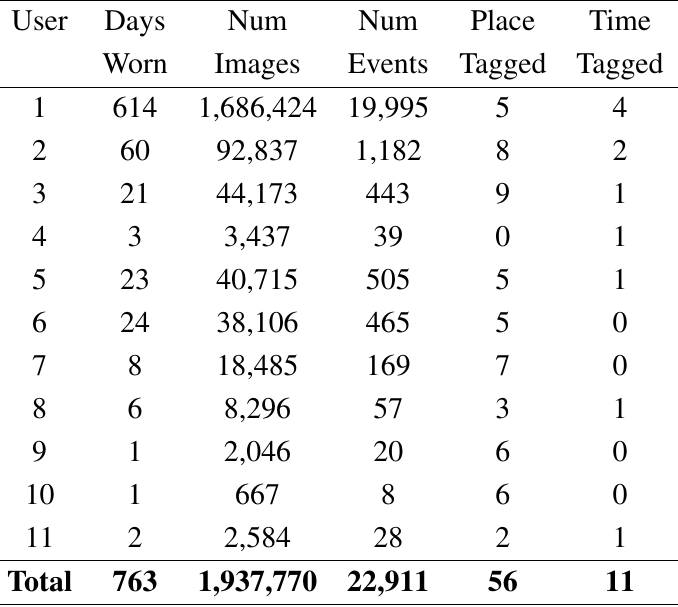
Table 2. Summary of data collected by our